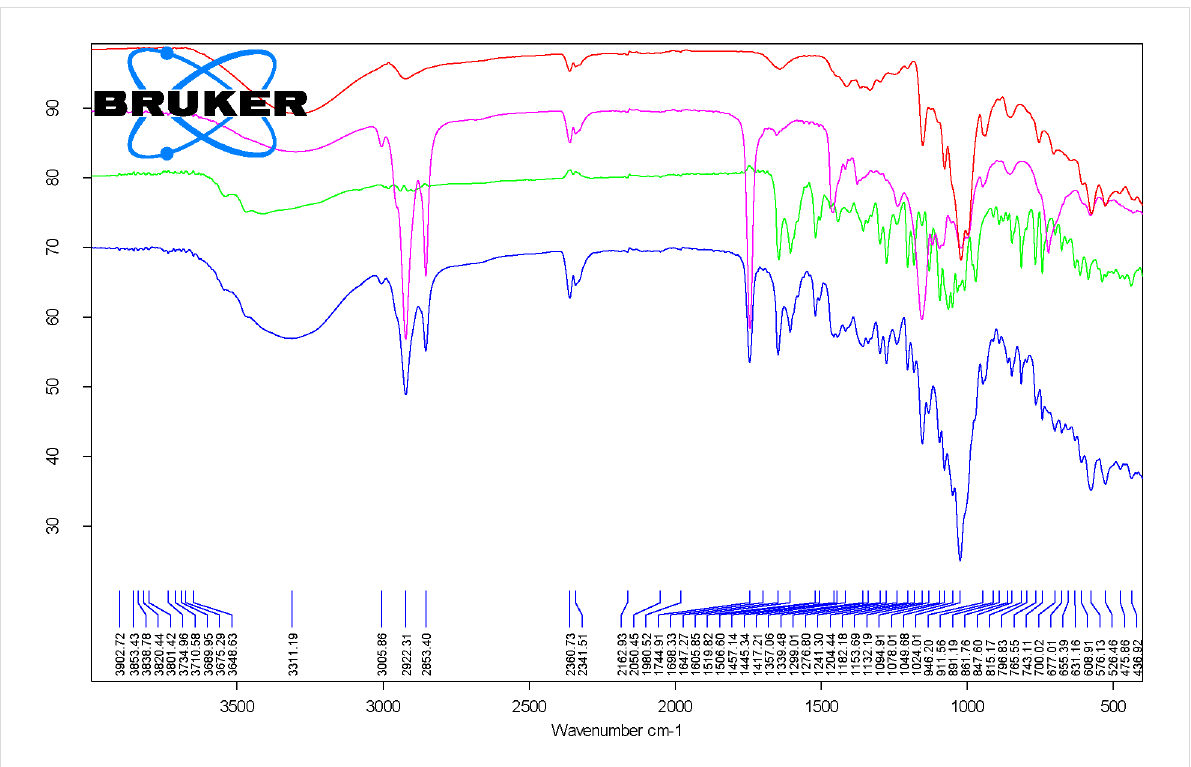
Figure 2: Superposition of the FTIR spectra for the β -cyclodextrin/ Corylus avellana oil/hesperidin ternary complex at a 1:1:1 molar ratio (blue), β -cyclodextrin hydrate (red), C. avellana oil (pink), and hesperidin